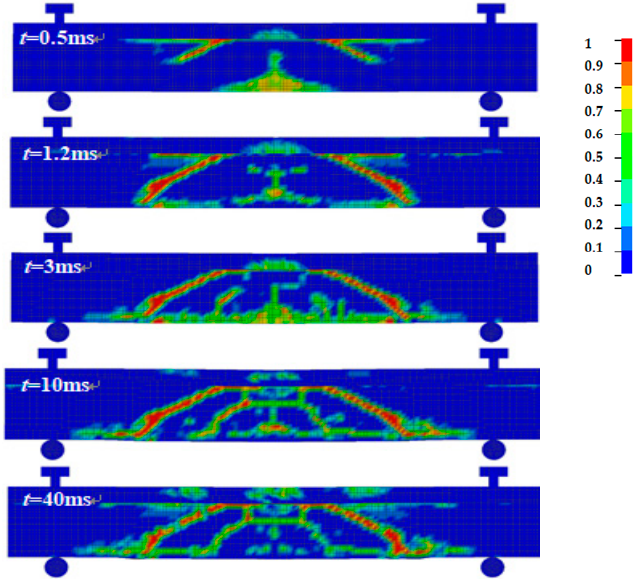
Figure 11. Crack patterns of RC T-beam without CFRP.